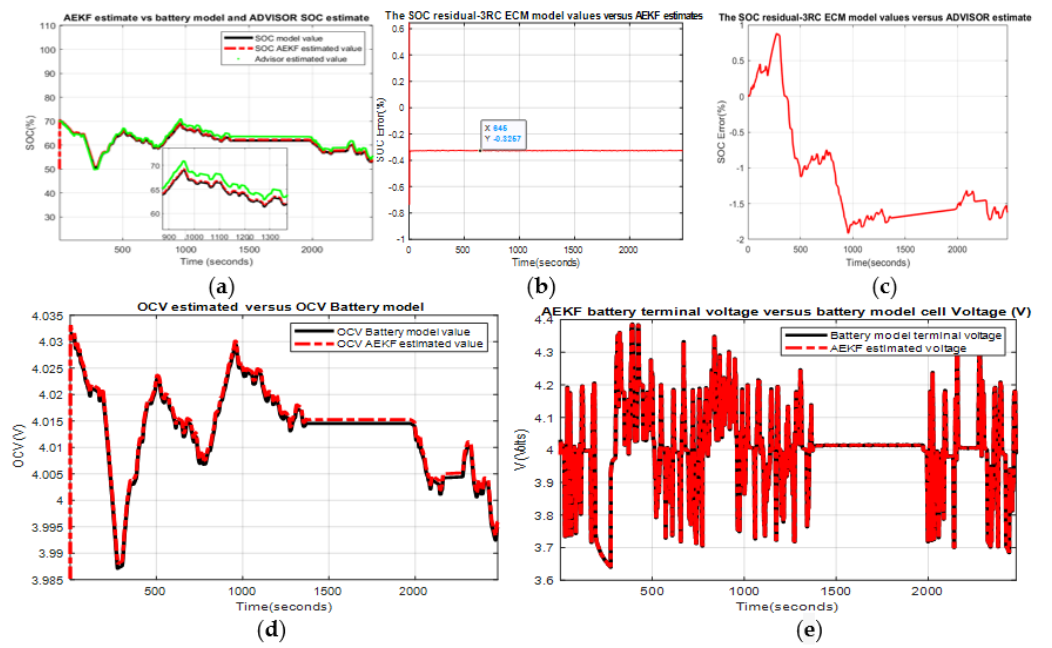
Figure 1. The Li-ion battery adaptive extended Kalman filter (AEKF) SOC and robustness performance for an initializing 20% SOC error (SOCini = 50%; SOCini for advanced vehicle simulator ADVISOR and battery model is 70%) ( a ) Li-ion battery model SOC (blue), ADVISOR SOC estimate (green), AEKF SOC (red); ( b ) SOC residual error AEKF vs ADVISOR SOC estimate; ( c ) SOC residual error AEKF vs battery model; ( d ) AEKF open-circuit voltage (OCV) vs battery model OCV (true value); ( e ) AEKF battery terminal output voltage vs battery model terminal output voltage (true